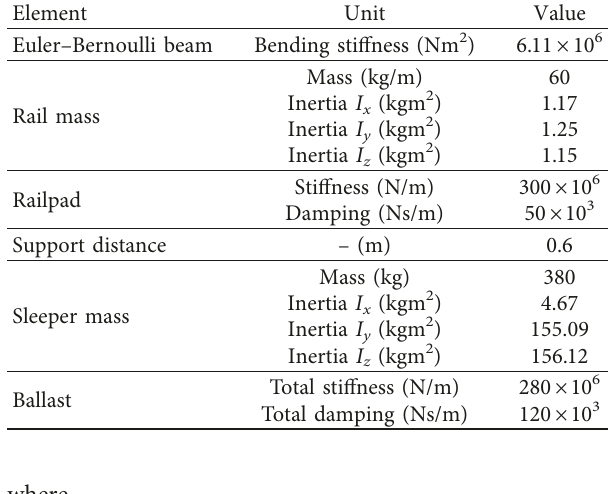
Figure 2: Receptance functions. Table 1: Track